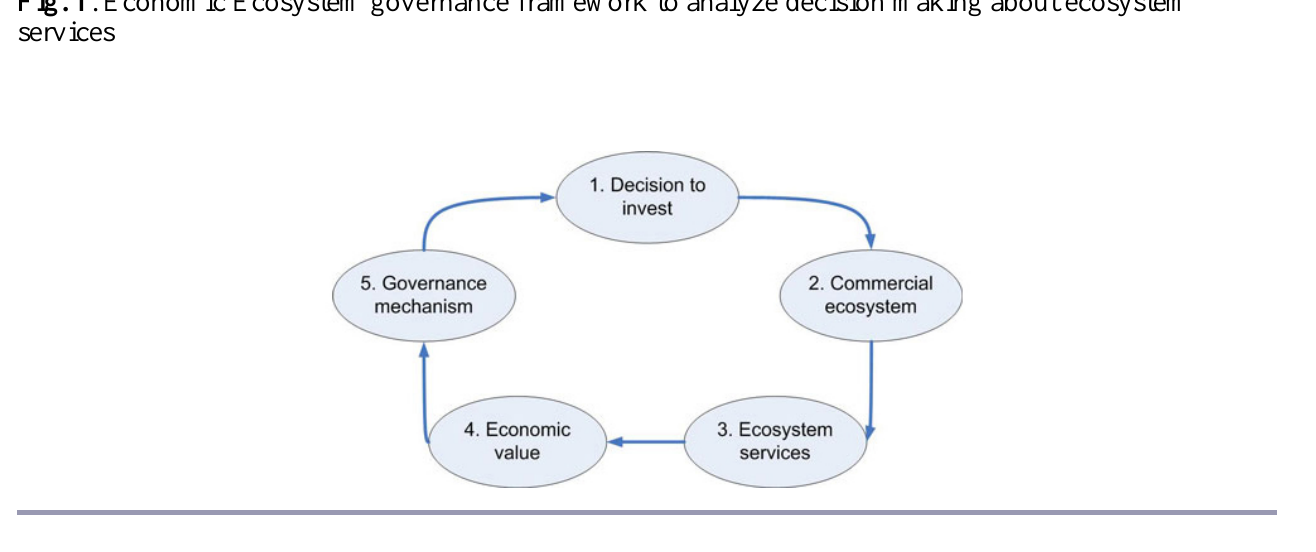
Fig. 1 . Economic Ecosystem governance framework to analyze decision making about ecosystem